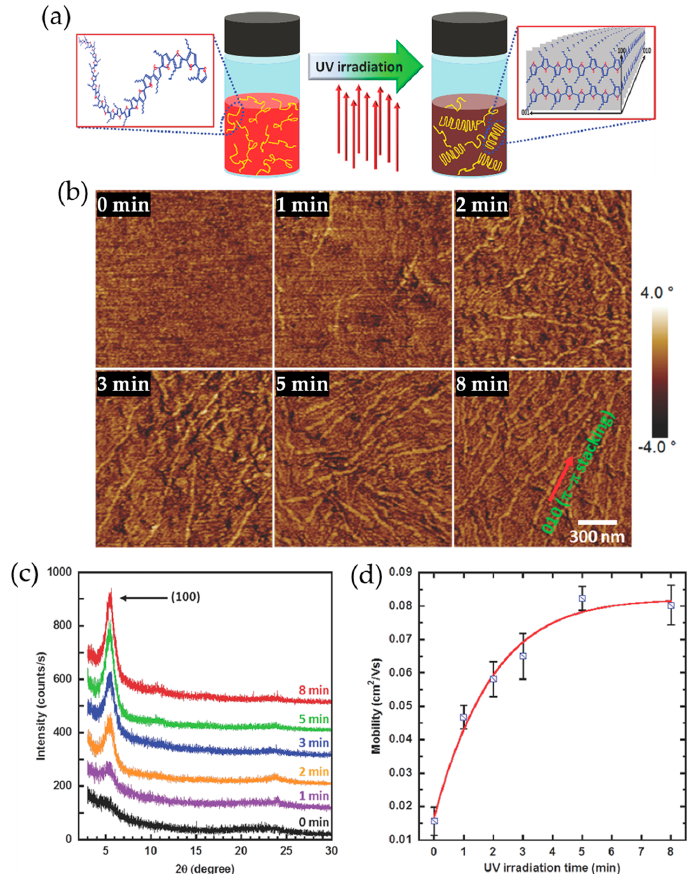
Figure 6. ( a ) Suggested mechanism for the UV irradiation induced anisotropic molecular ordering of P3HT chains; ( b ) tapping mode AFM phase images of P3HT films obtained by spin coating chloroform-P3HT solutions irradiated by UV for 0, 1, 2, 3, 5, and 8 min; ( c ) grazing incidence X-ray diffraction profiles; and ( d ) average field-effect mobilities of corresponding P3HT films. Reproduced with permission from [68]. Copyright 2014 WILEY-VCH Verlag GmbH & Co. KGaA, Weinheim.